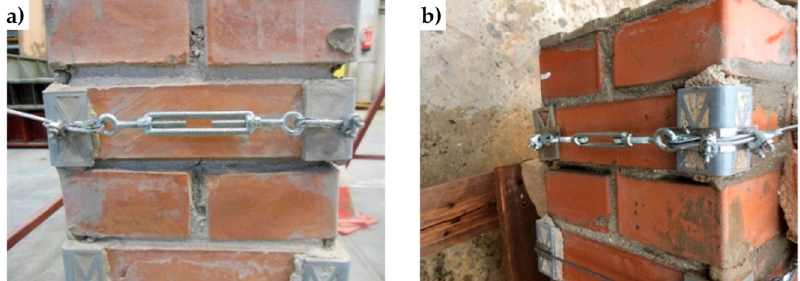
Figure 54. The clamping system of the second combined technique: ( a ) detail of the clamping system along the thickness of the brick wall (23 cm) and ( b ) detail of the two clips at the corner of the brick wall.